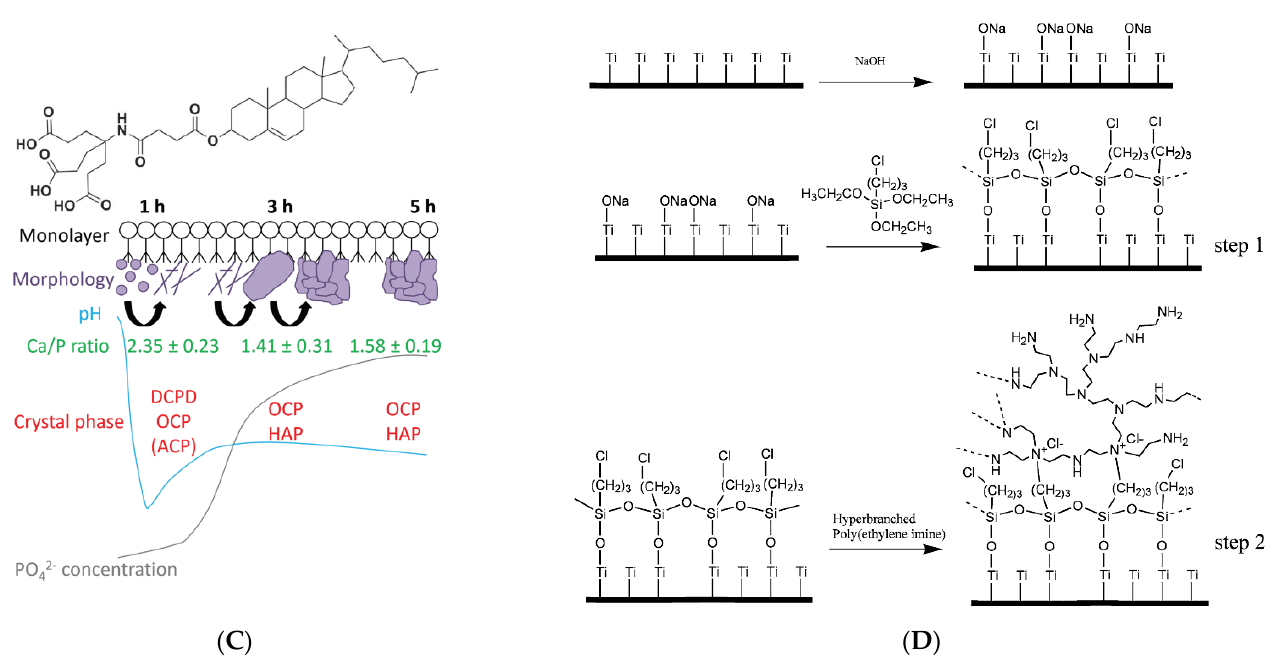
Figure 12. ( A ) ( a ) Two-dimensional cryo-TEM images of different stages of surface-induced apatite nucleation from simulated body fluid. Scale bar = 50 nm. ( b ) Computer-aided three-dimensional visualizations of tomograms. The inset Selected area (electron) diffraction (SAED) at stage 4 shows the amorphous spherical particles attached to the monolayer. The inset SAED at stage 5 can be indexed as carbonated HAP with a [110] zone axis. ( c ) Scheme of the mineralization process Stage 1: loose aggregation of prenucleation clusters in equilibrium with ions in solution. Stage 2: prenucleation clusters aggregate in the presence of the monolayer with loose aggregates still present in the solution. Stage 3: aggregation leads to densification near the monolayer. Stage 4: nucleation of amorphous spherical particles only at the monolayer surface. Stage 5: development of crystallinity following the oriented nucleation directed by the monolayer. Reproduced with permission from [150] Copyright: Nature Publishing Group and [168]. Copyright: Nature Publishing Group. ( B ) Possible mechanisms of slow hydroxyapatite growth. ( a ) Dendrimer as a nucleus for hydroxyapatite precip- itation and growth. ( b ) Dendrimer supramolecular aggregate as a nucleus for hydroxyapatite pre- cipitation and growth. Reproduced with permission from [154]. Copyright: Elsevier Science B.V. ( C ) Structure of the Cholesteryl Newkome-type dendron amphiphile and different Ca 3 (PO 4 ) 2 crystal shapes as a function of nucleation time. Reproduced with permission from [158] Copyright: WILEY-